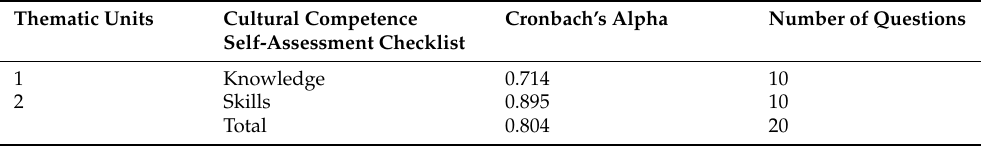
Table 1. Internal Consistency